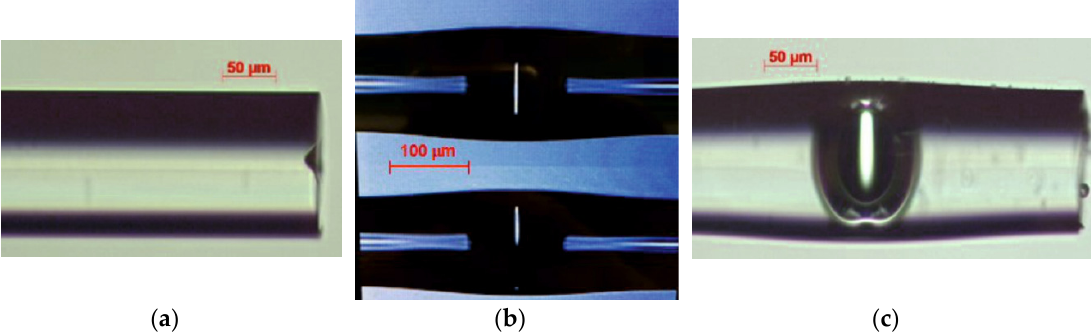
Figure 5. ( a ) Microphotograph of a microhole in the optical fiber’s tip, ( b ) splicer image of the air Figure 5. (a) Microphotograph of a microhole in the optical fiber’s tip, (b) splicer image of the air bubble, obtained just after electric arc discharge, and ( c ) microscope image of a cleaved FP fiber tip, bubble, obtained just after electric arc discharge, and (c) microscope image of a cleaved FP fiber tip, with L 1 = 105 µ m and L 2 = 149 µ with L 1 = 105 µm and L 2 = 149 µm.